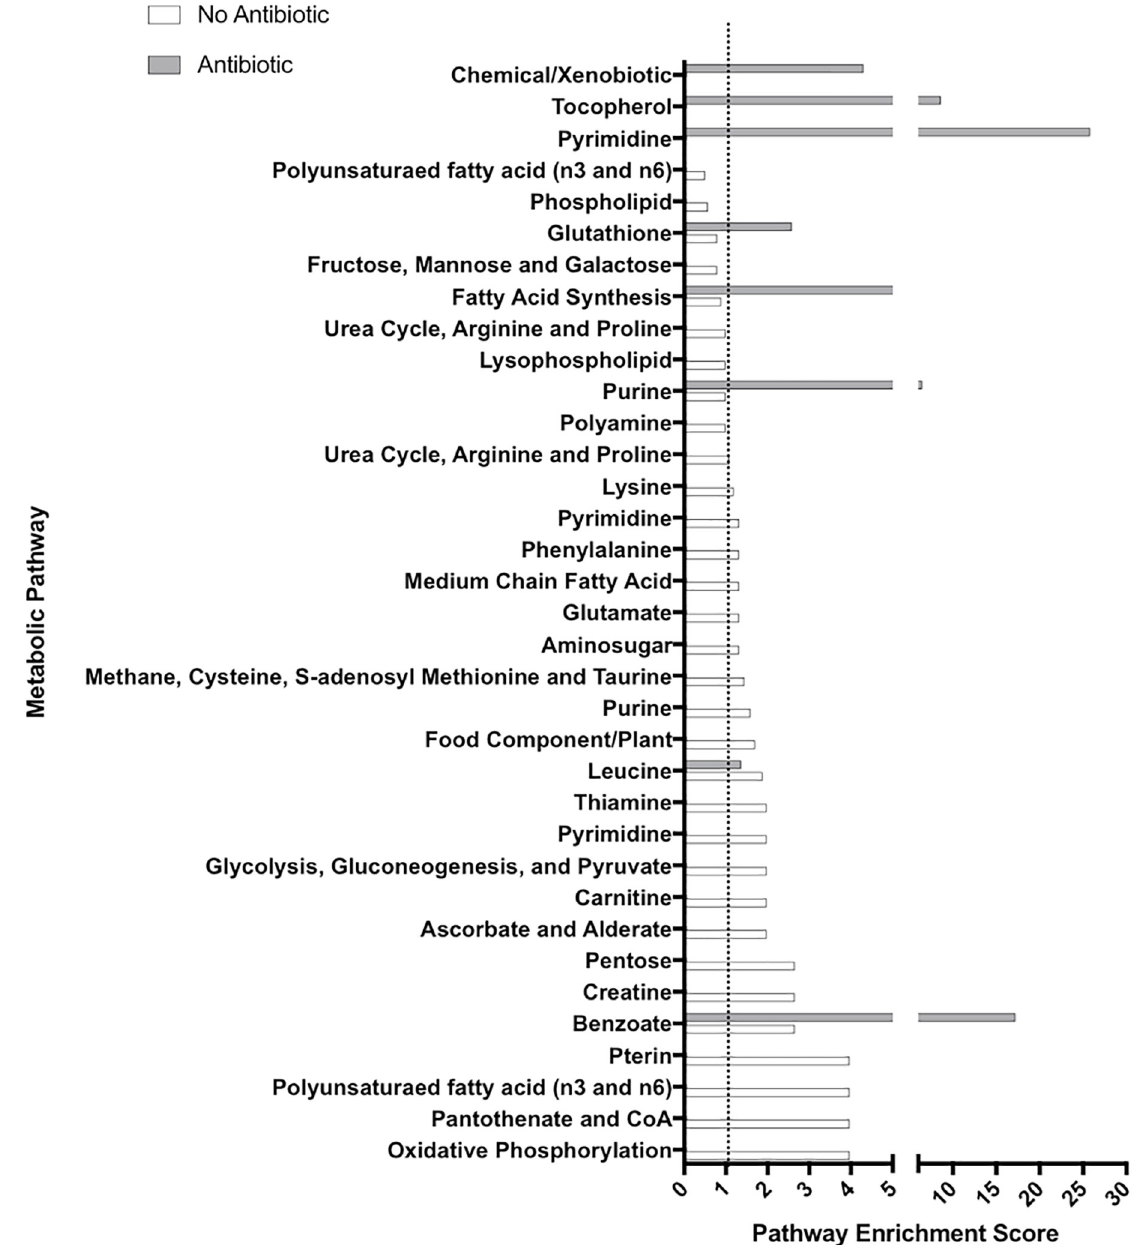
Fig 5. Pathway enrichment scores were calculated for 100 mmHg versus 5.9 mmHg oxygen in both the presence of antibiotic (grey) and absence of antibiotic (white). Bars that extend past the dotted line (at a score of 1) were considered the primary pathways contributing to treatment differences. Lack of a white or grey line for any pathway indicates that no metabolites were statistically-different between treatments (p < 0.05) within that